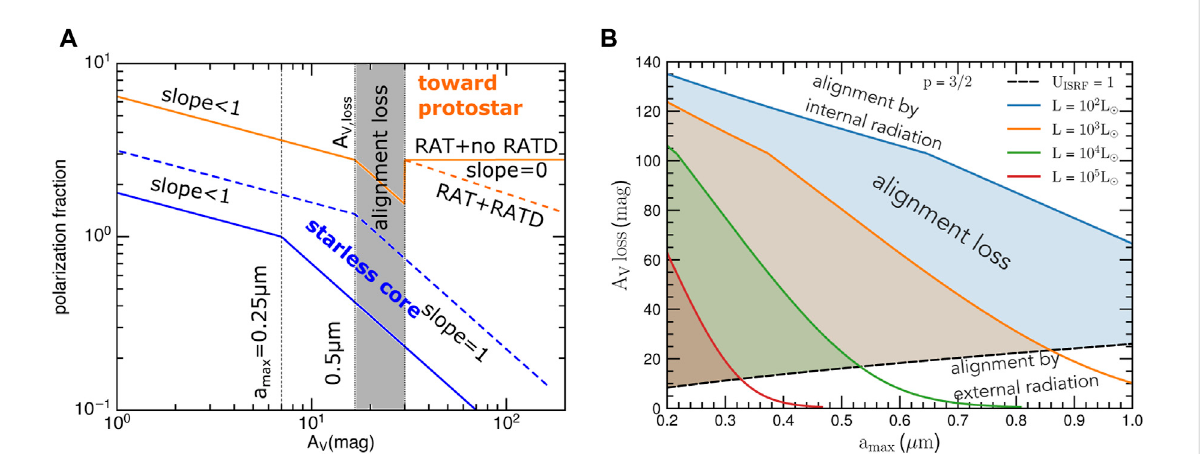
FIGURE 15 (A) Variation of the polarization fraction (arbitrary unit) with the visual extinction expected from the RAT paradigm, described by p ∝ A − ξ V . The blue lines are for a starless core with two values of the maximum grain size (solid and dashed lines). The slope changes from ξ < 1 to ξ = 1 when grain alignment is completely lost, highlighted by two dotted vertical lines. The orange line is for a protostellar core. Similarly, the shaded region indicates the range of A V where grain alignment is completely lost. Nevertheless, the internal radiation increases the alignment of grains near the source, changing the slope from ξ = 1 to ξ = 0 in the absence of RAT-D and to ξ > 0 in the presence of RAT-D. Uniform magnetic fi eld geometry is assumed. (B) Variation of the A V ,loss above which grain alignment by RATs is completely lost (i.e., a align ≥ a max ), as a function of a max for high-mass protostars. Solid lines show the results for grain alignment induced by central protostars of different luminosity. The black dashed line shows grain alignment induced by attenuated ISRF. The shaded region indicates the parameter space for complete alignment loss. Stellar temperature T * = 10 4 K and gas density ∝ r − 3/2 are adopted. Figure adopted from Hoang et al.